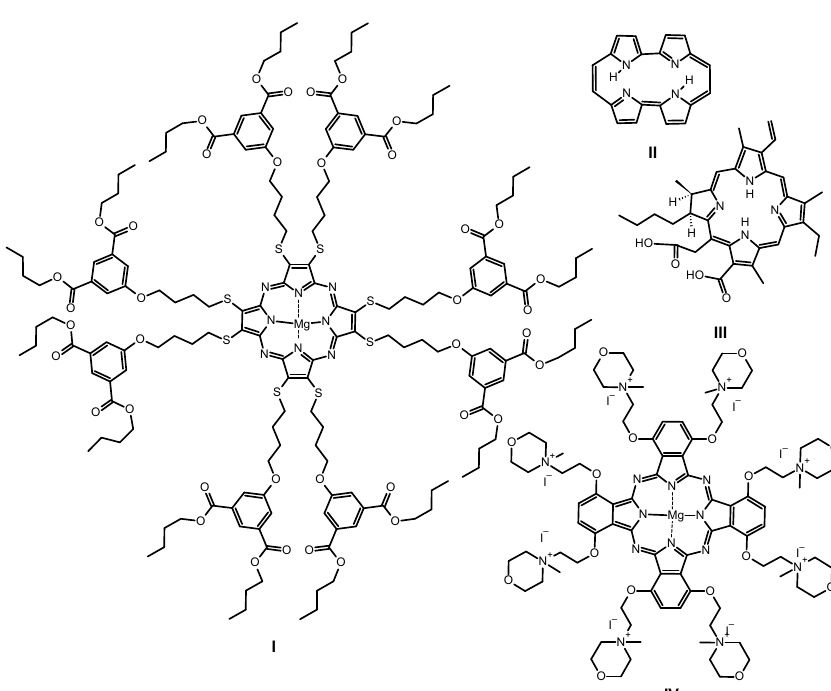
Figure 3. Chemical structures of previously studied macrocycles: sulfanylporphyrazine with isophthaloxybutyl substituents I, porphycene II, chlorin e6 III and phthalocyanine with quaternized morpholinethoxy substituents IV.